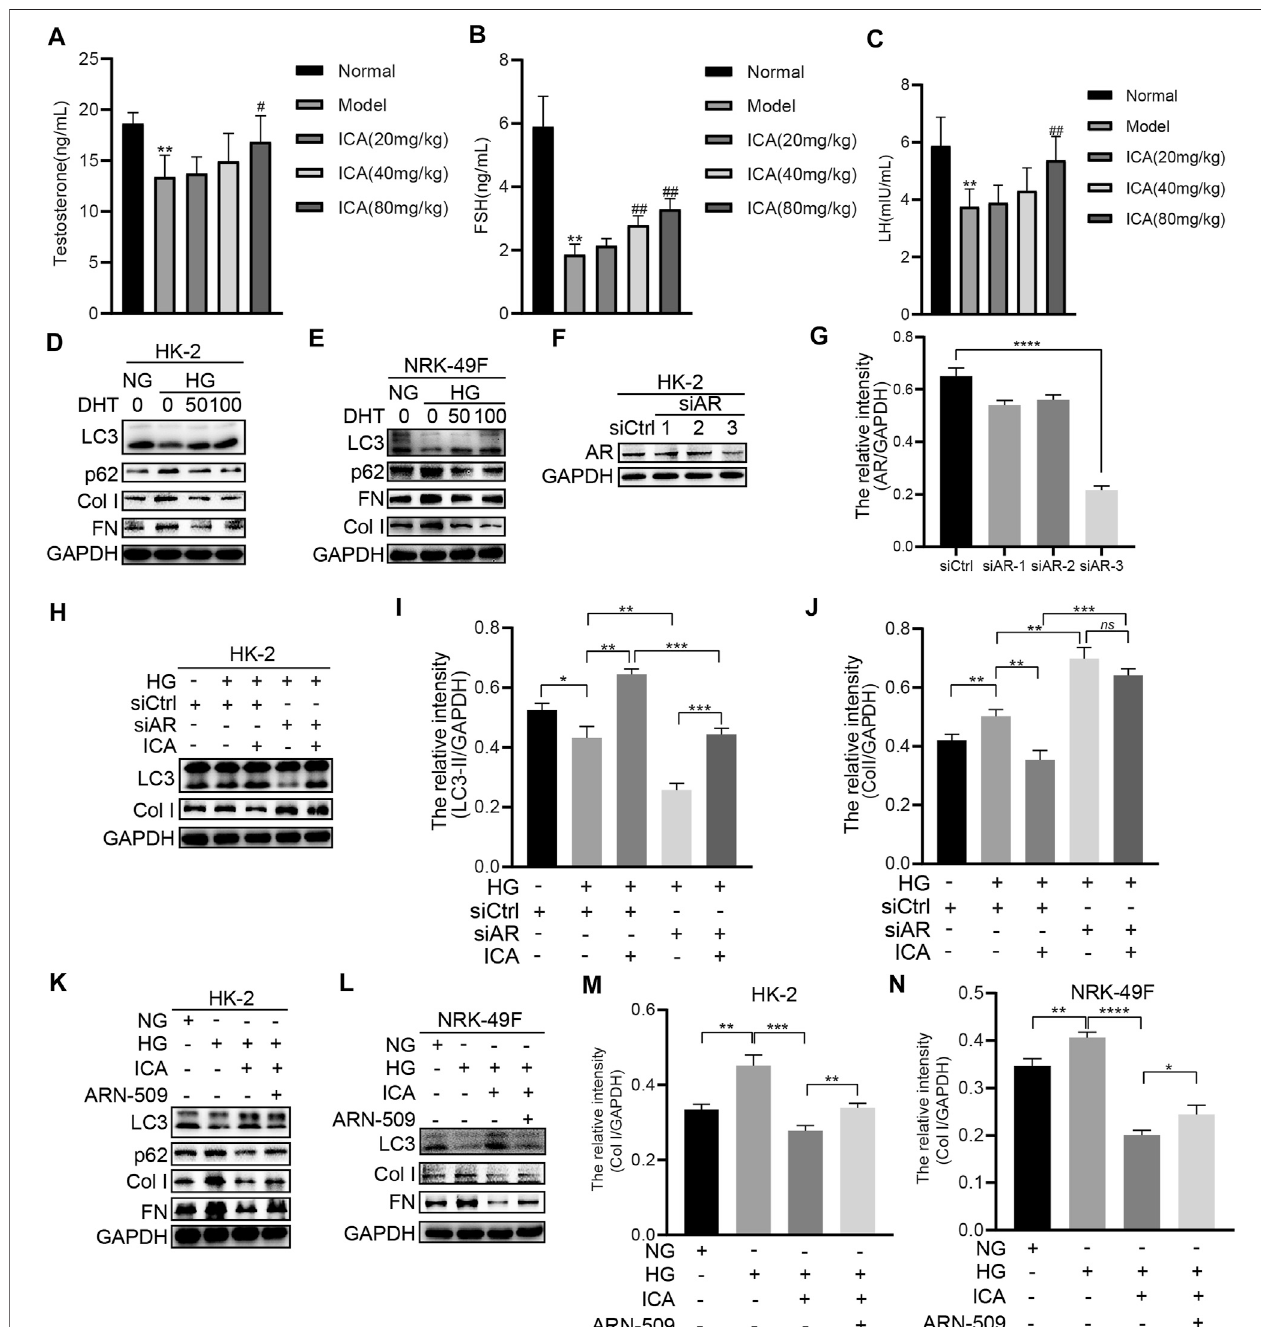
FIGURE 4 | ICA induces autophagy and reduces fi brosis by regulating AR (A – C) The serum testosterone, FSH, and LH concentrations were detected by ELISA. Dataareexpressed as mean ± SD ( n (cid:1) 8).** p < 0.01, vs theNormal group; # p < 0.05, ## p < 0.01, vs theModel group (D – E) HK-2and NRK-49F cellswere treated with HG and DHT for 48 h, then the expression of LC3, p62, Col I, and FN was detected by Western blot (F – J) HK-2 cells were transfected with siAR or NC, then treated with or without ICA (50 μ M), the expression of AR, LC3, and Col I was evaluated by Western blot and analyzed by the ChemiScope analysis software (* p < 0.05, ** p < 0.01, *** p < 0.001, **** p < 0.0001) (K – N) HK-2 and NRK-49F cells were treated with HG, ICA (50 μ M) or ARN-509 (80 nM), and the expression of LC3, p62, Col I, and FN was detected by Western blot and the relative intensity of Col I was analyzed by the ChemiScope analysis software (* p < 0.05, ** p < 0.01, *** p < 0.001, **** p < 0.0001).